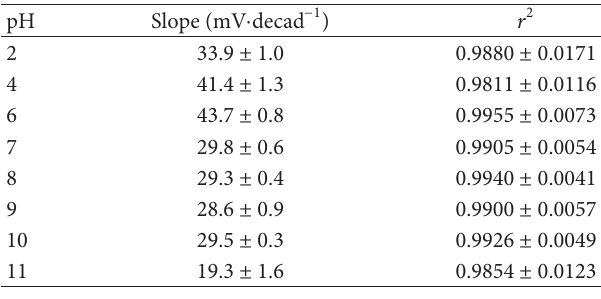
T 5: Effect of pH on Nernstian behavior of the chromate- selective electrode (